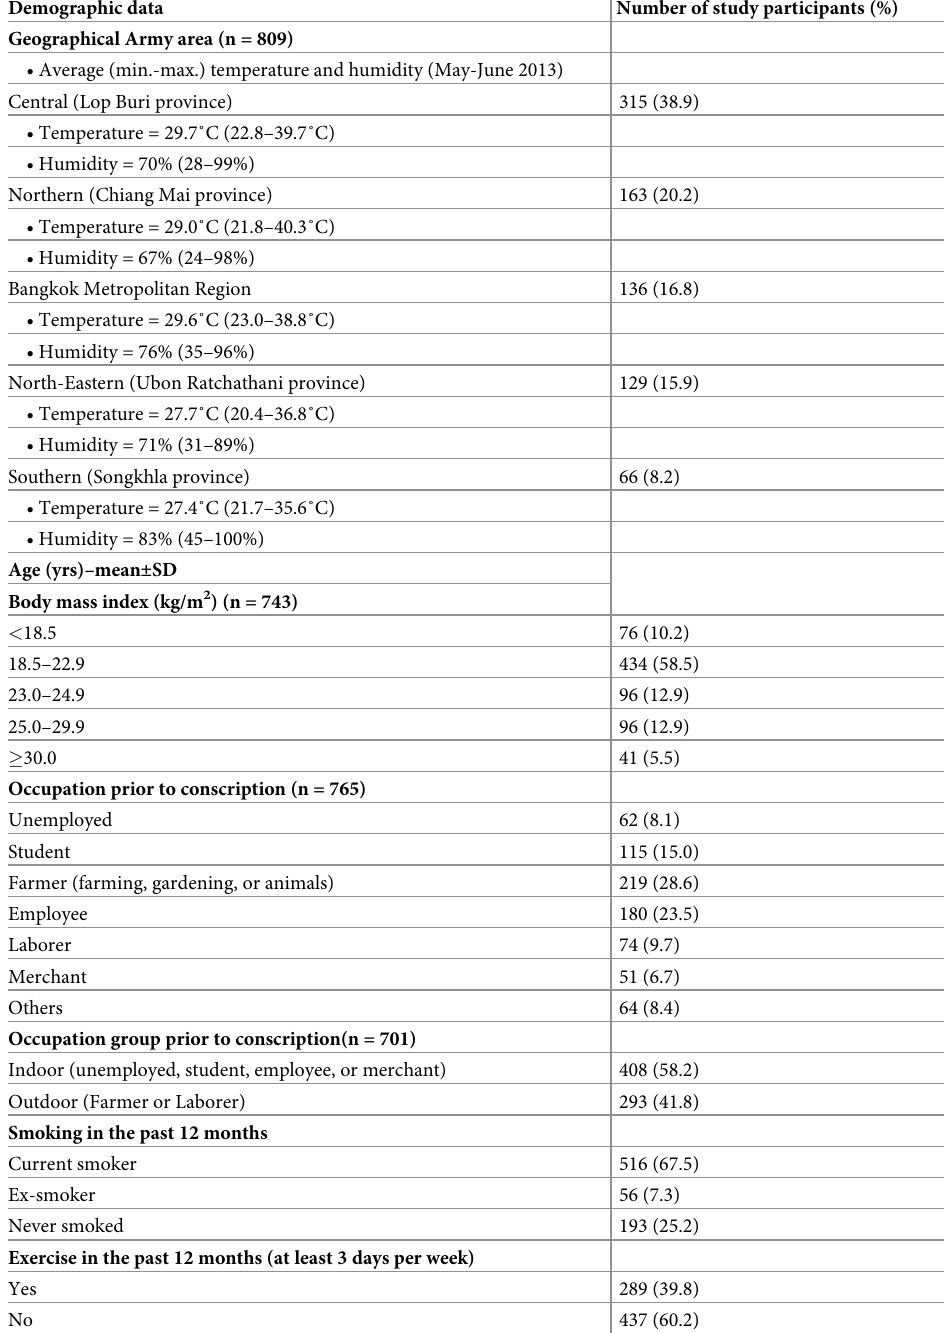
Table 1. Demographic